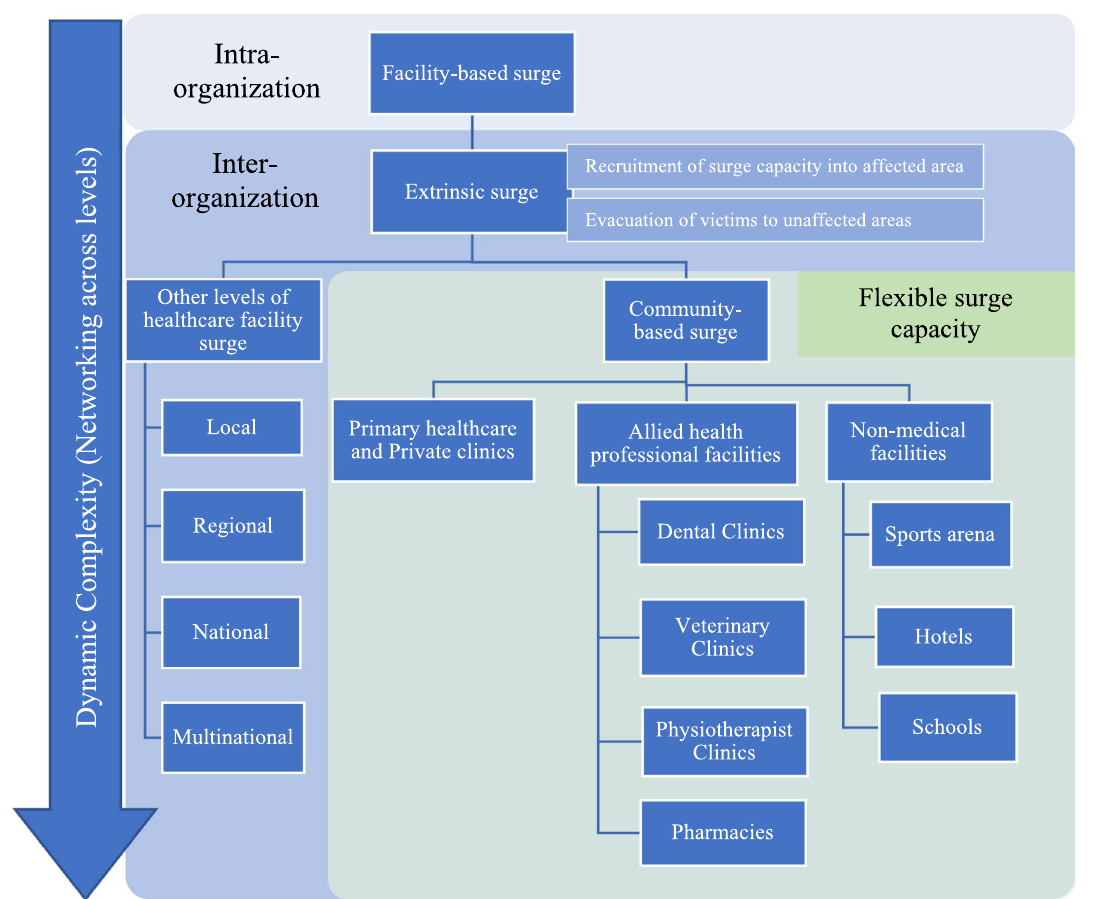
Fig. 1 Surge capacity framework incorporating the flexible surge capacity concept. Source Phattharapornjaroen et al.